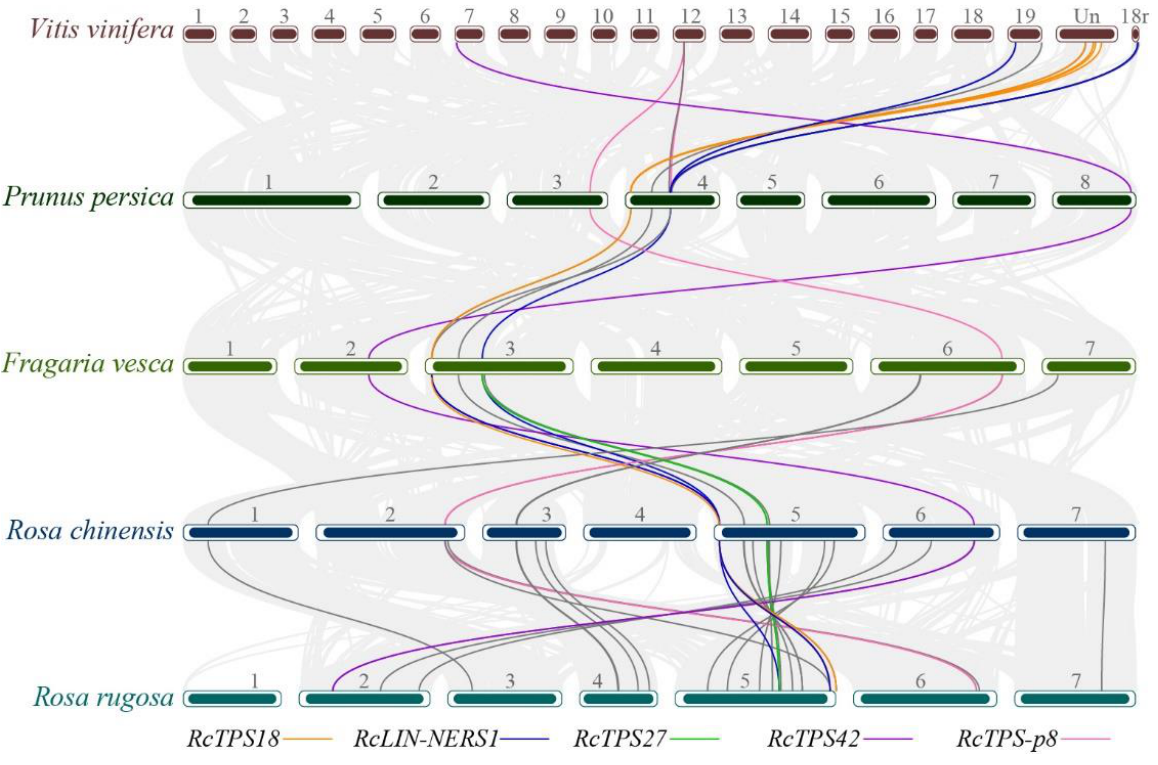
Figure 4. Collinearity analysis of TPS genes among R. chinensis and other representative plant species. Gray lines in the background indicate the collinear blocks between rose and other plant genomes . The color and black lines highlight the syntenic TPS gene pairs.